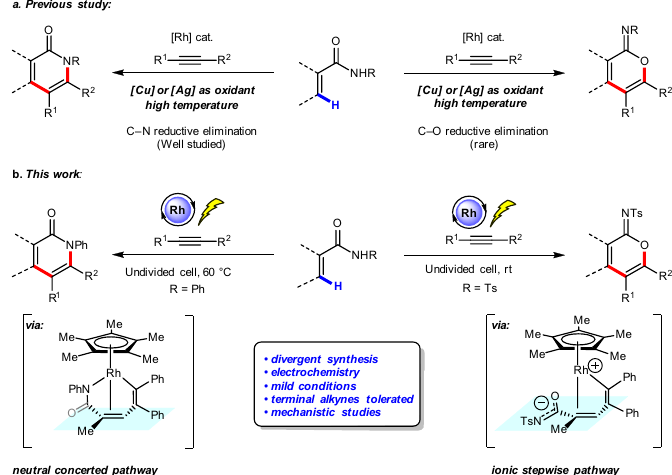
Fig. 1 Rh-catalyzed vinylic C – H annulation of acrylamides with alkynes to afford α -pyridone and cyclic imidate. a Rh-catalyzed vinylic C – H annulation under elevated temperature with stoichiometric transition metal oxidants. b Rh-catalyzed electrochemical vinylic C – H annulation of acrylamides with alkynes.